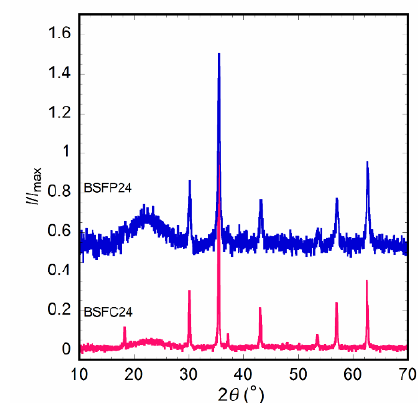
Fig. 4 XRD patterns of the magnetite-based glass- ceramics obtained from the crystallization of Fe-containing borosilicate glass melts. Both the background and K  2 contributions were subtracted from each graph. All peaks belong to